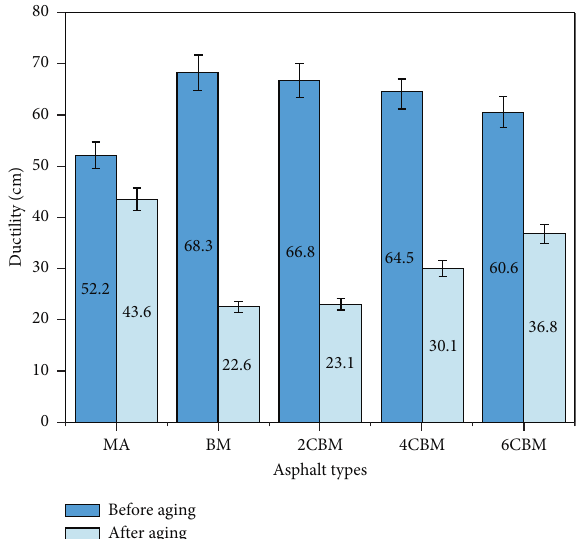
Figure 4: Effect of organic nano-CaCO 3 on the ductility of bioasphalt before and after aging.